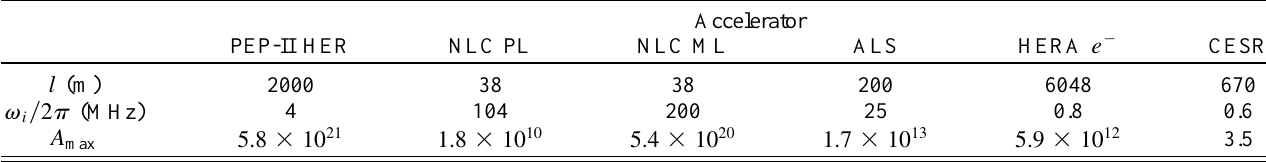
TABLE I. Maximum amplification for the asymptotic